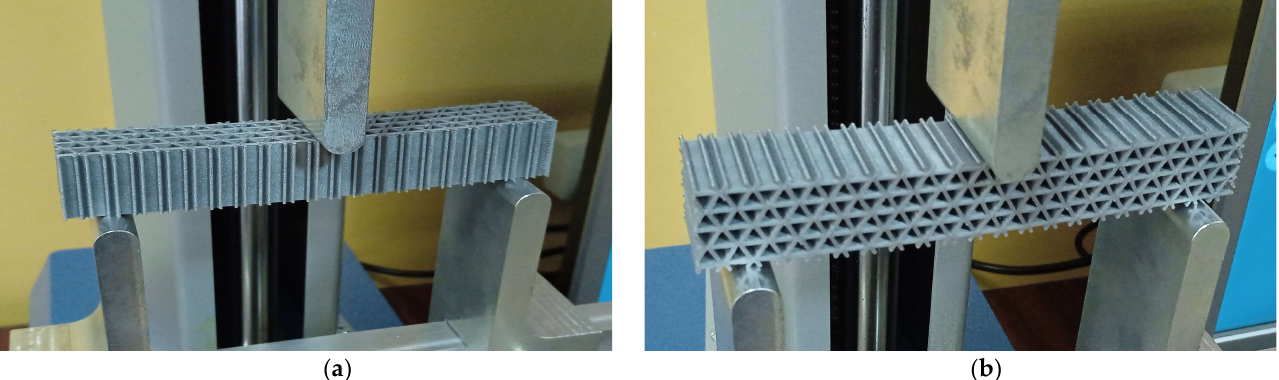
Figure 10. The 3-point bending setup for the triangle cell specimen: ( a ) force along the Y-axis of the specimen, ( b ) force along the Z-axis of the specimen.